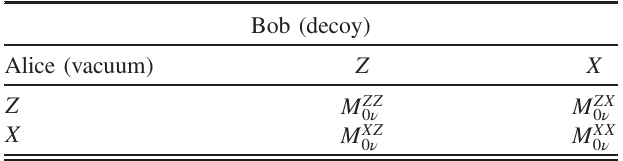
TABLE II. M 0 ν consists of four